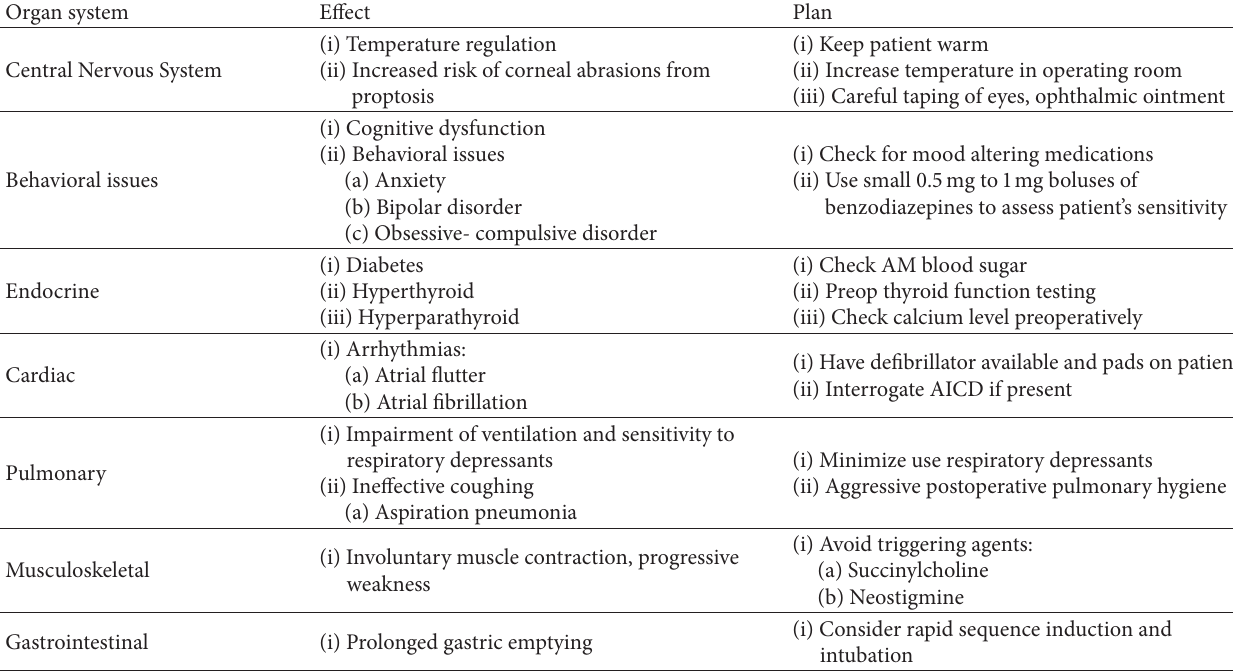
Table 2: Summary of DM effects and practice suggestions for perioperative management of patients with